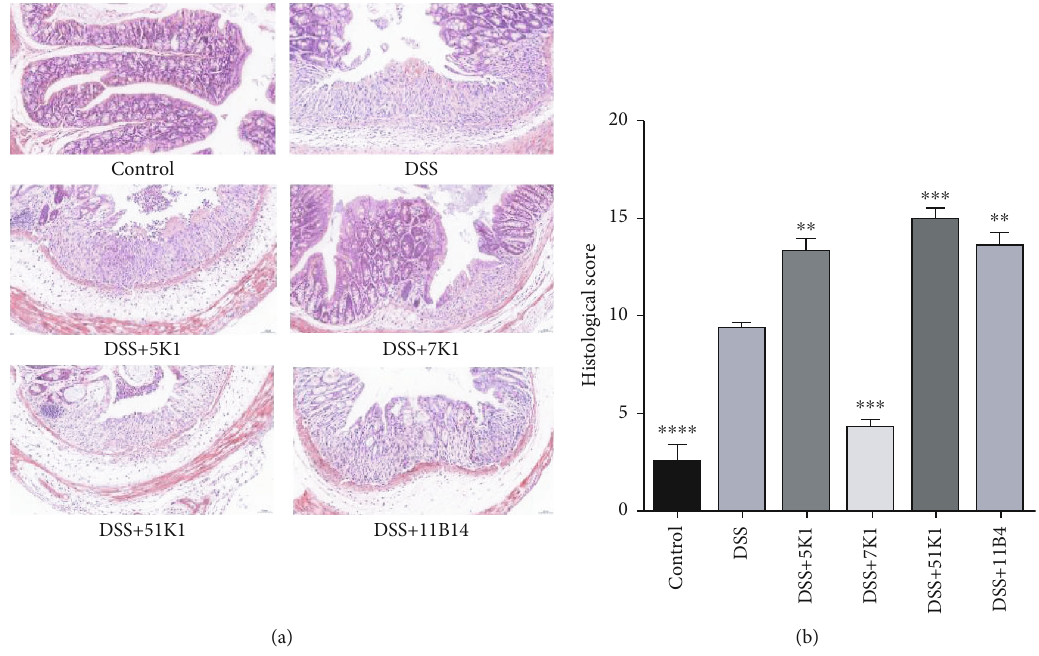
Figure 4: E ff ects of Bacteroides vulgatus on colonic tissue injury in mice. (a) Histological images. (b) Histological score. Four mice for the control group and three mice for each of the other